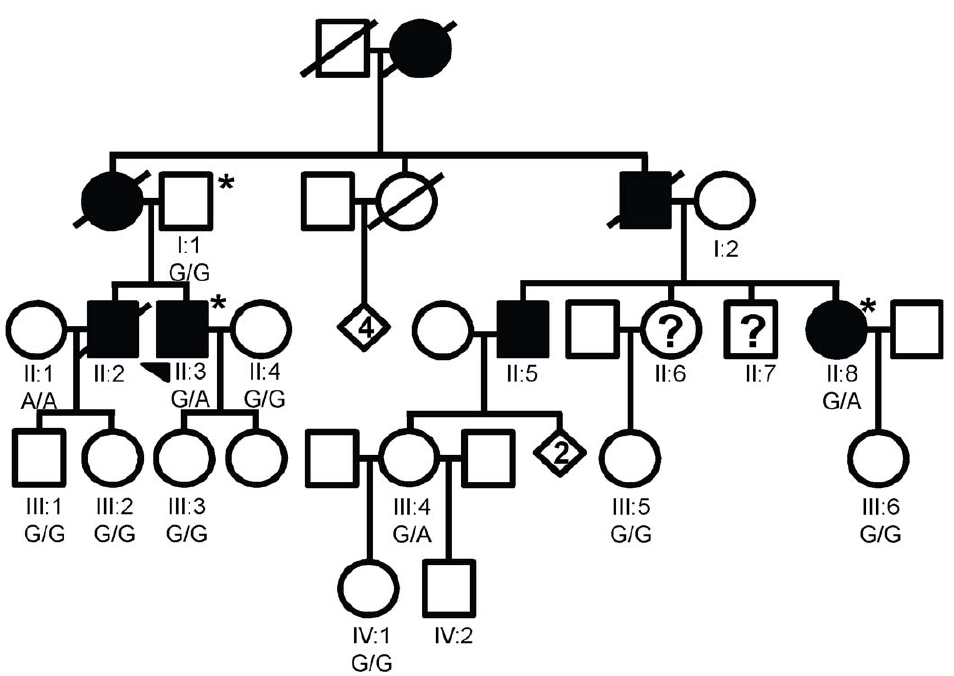
Figure 2. LGMD2692 pedigree and results of Sanger sequencing for FLNC p.W2710X. The pedigree shows the affection statuses, individual identifiers, and genotypes at FLNC p.2710. The genotypes obtained through Sanger sequencing of individuals with available high quality DNA are shown. The arrow indicates the proband. * indicates that DNA was sent for exome sequencing. Individuals with ? were of uncertain affection status.